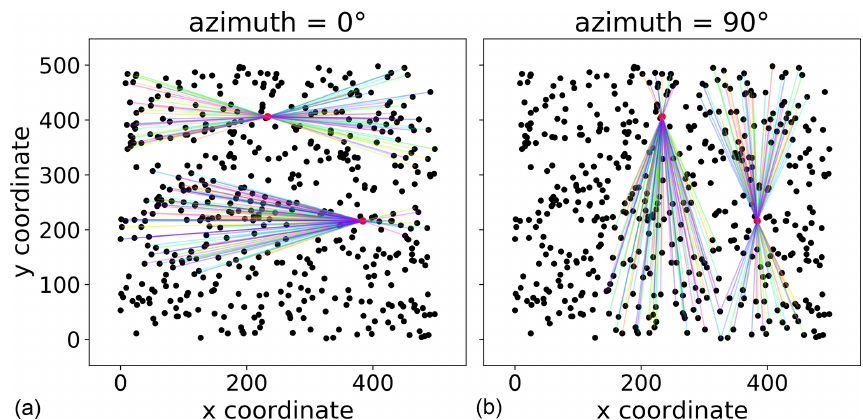
Figure 11. Pair Field plot of two directional variograms. The plot was created with exactly the same two directional variogram instances as used in Fig. 5. Panels (a) and (b) show the network graph for two observation points (index 42 and 170 in the sample file), in both directions of the variogram. The lines connect all point pairs that were taken into account for these two points. The line colors have no meaning and are just included for visual